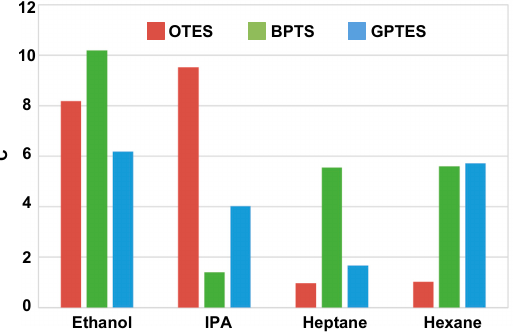
Figure 9. Concentration-independent code bars.